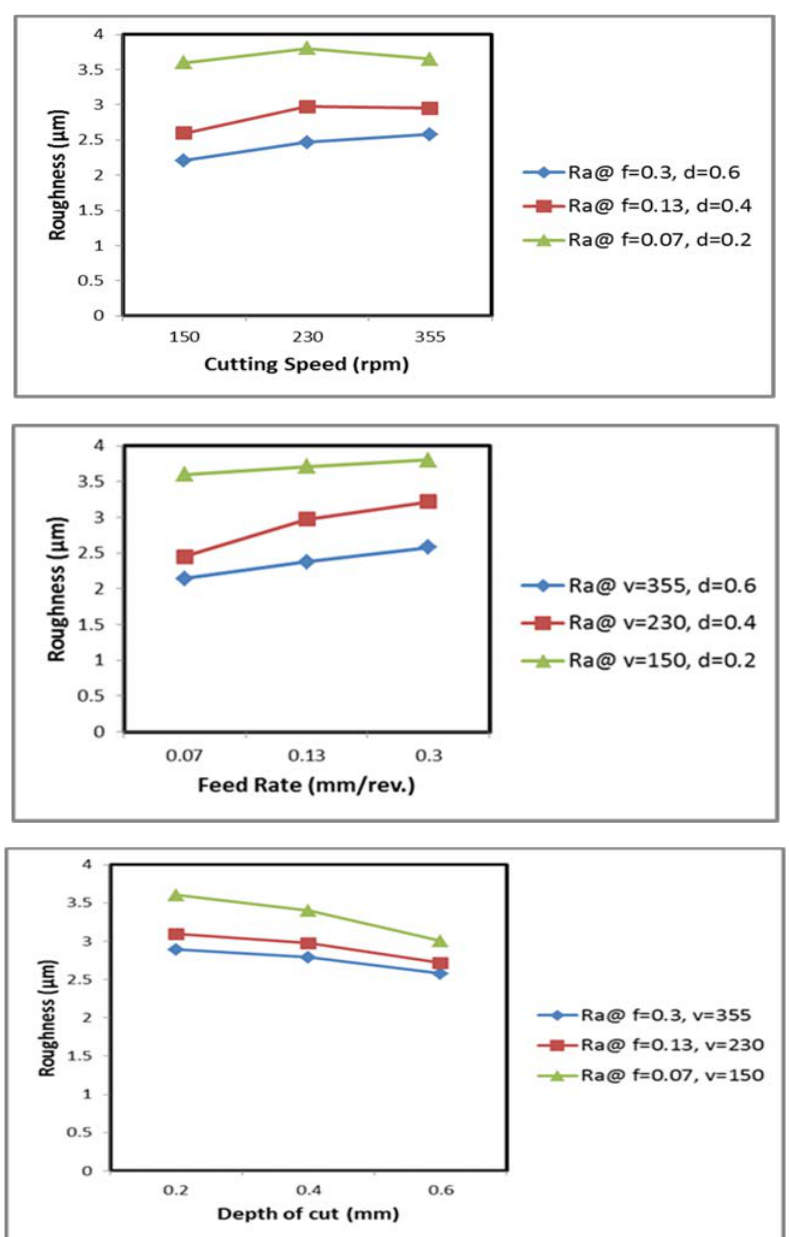
Fig. 5. Main effect plots of